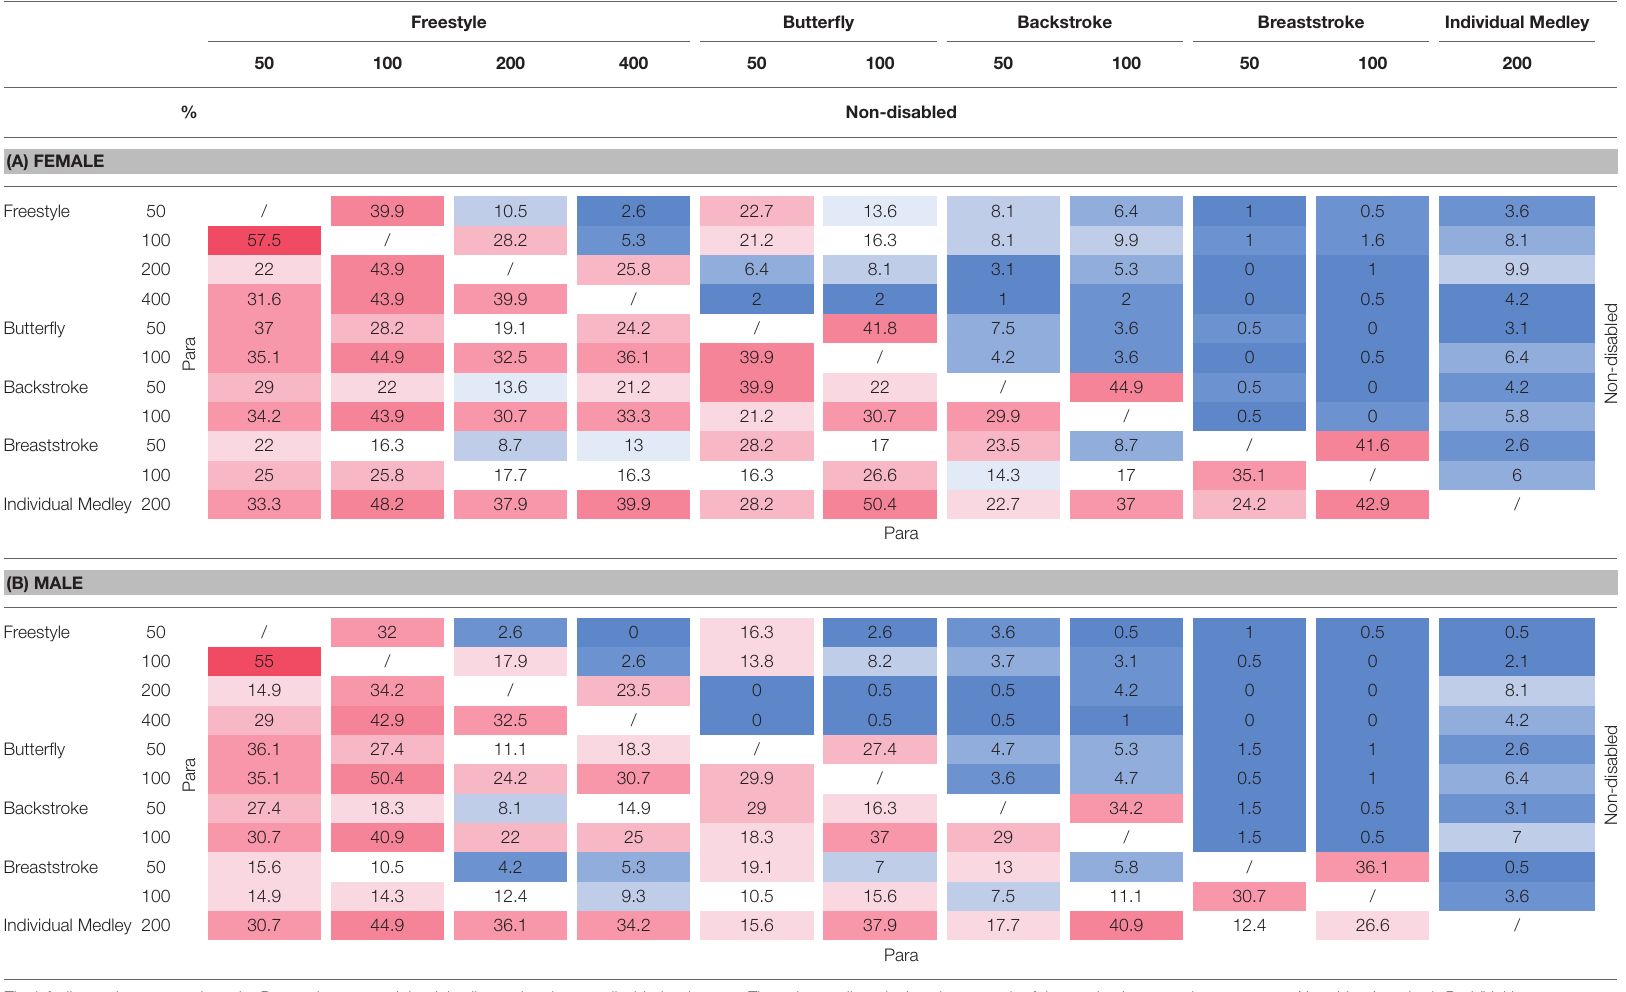
TABLE 1 | Percentage (%) of female (A) and male (B) swimmers who perform each combination of two race events related to the total number of swimmers in these two events. Freestyle Butterfly Backstroke Breaststroke Individual Medley 50 100 Non-disabled